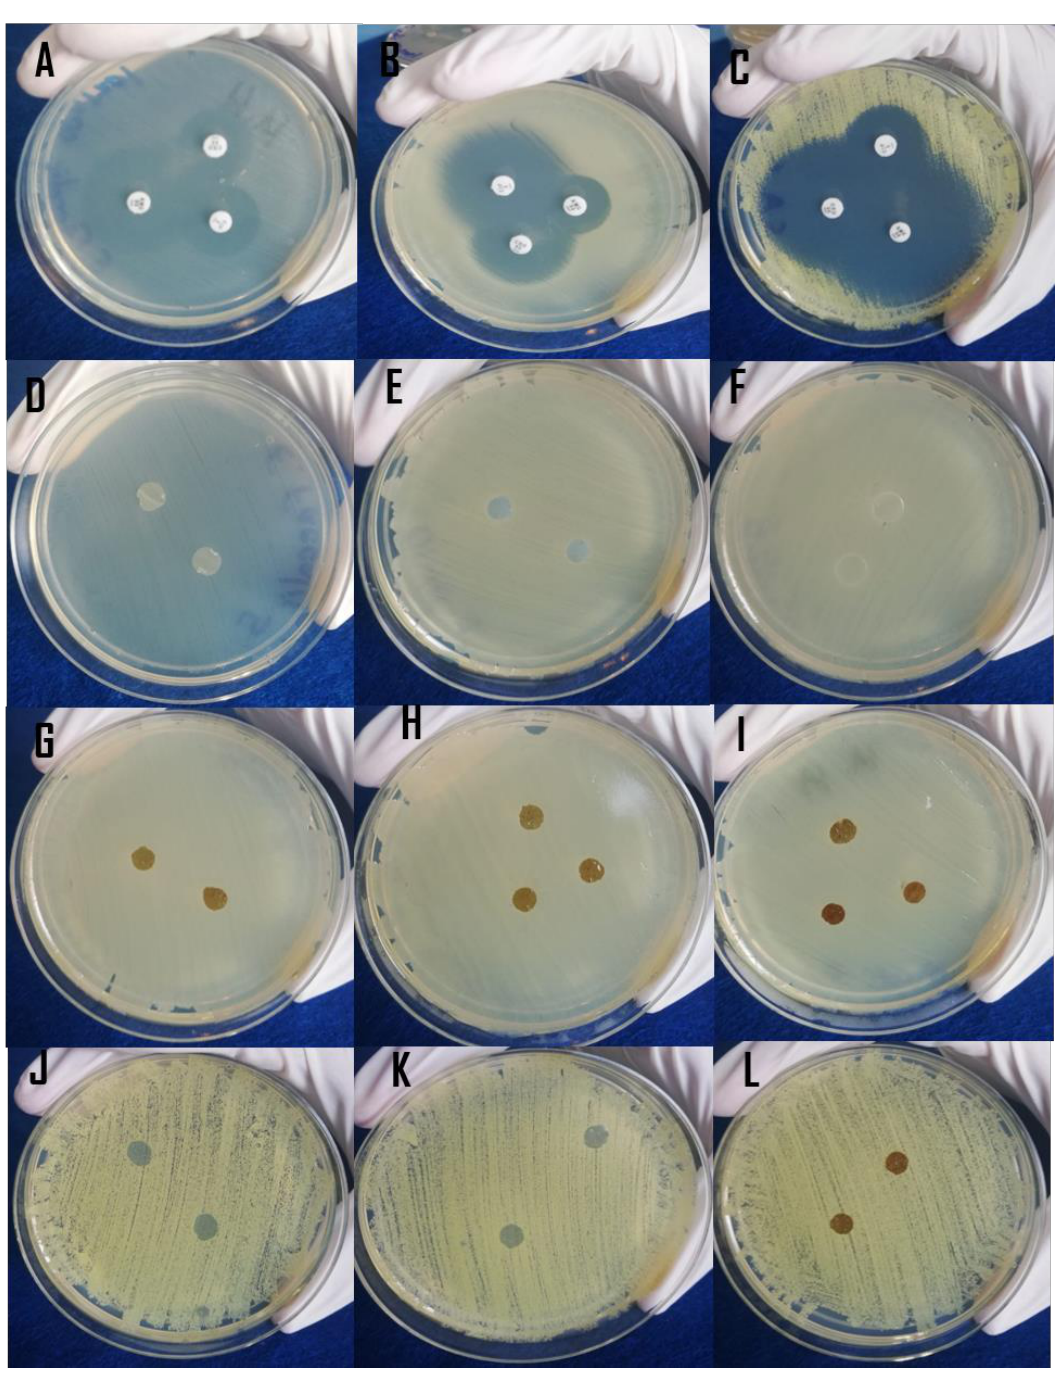
Figure 9. Inhibitory halo of antibiotics in contact with different strain (( A ) E. faecalis , ( B ) E. coli and ( C ) S. aureus ) and chitosan/HNa discs in contact with: E. faecalis ( D ), E. coli ( E – I ) and S. aureus ( J – L ).